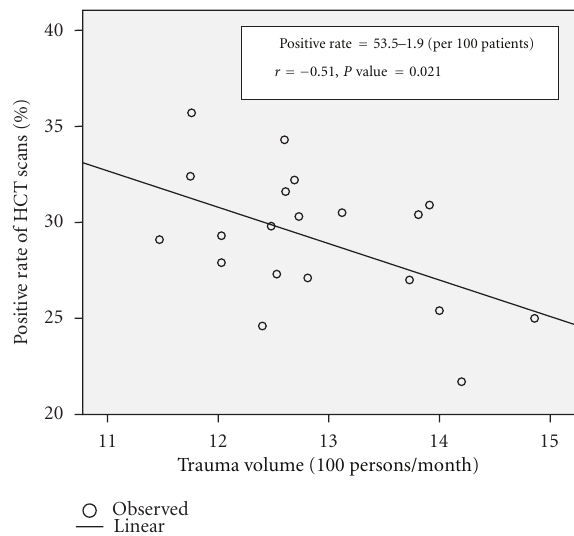
Figure 1: The relationship between monthly trauma volume and positive rate of head CT scans in 20 eligible samples.